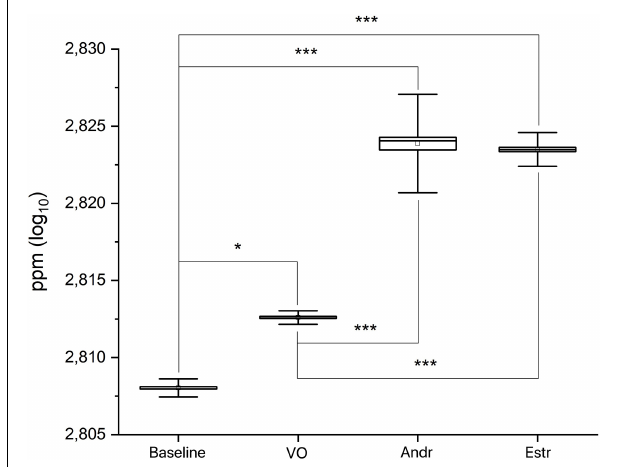
FIGURE 4 | Superimposition of volatile compounds frequency profile recorded, respectively, from EBM and EBM conditioned with VO, Andr, and Estr ( ∗ p ≤ 0.05; ∗∗∗ p < 0.001).